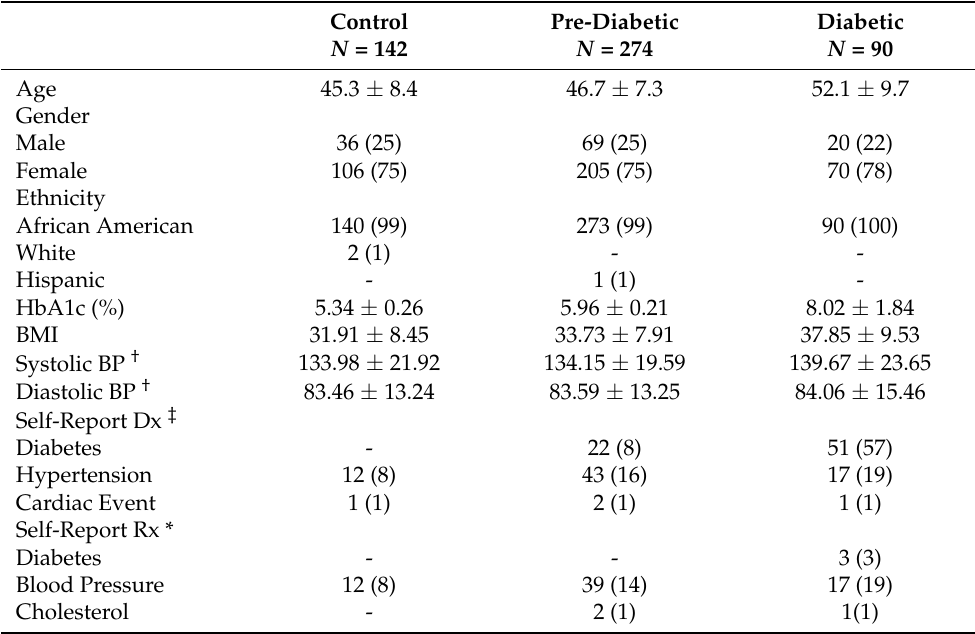
Table 1. Clinical and demographic characteristics of subjects.